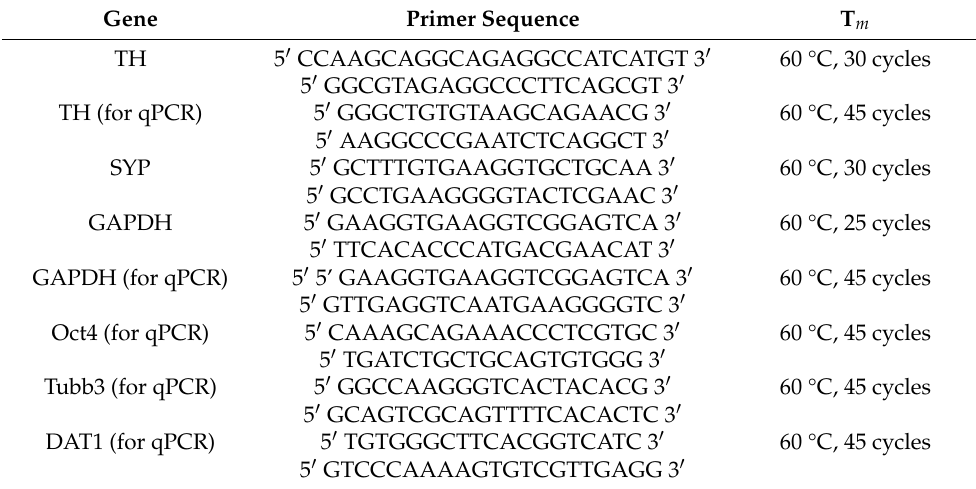
Table 4. Primers used in this study.